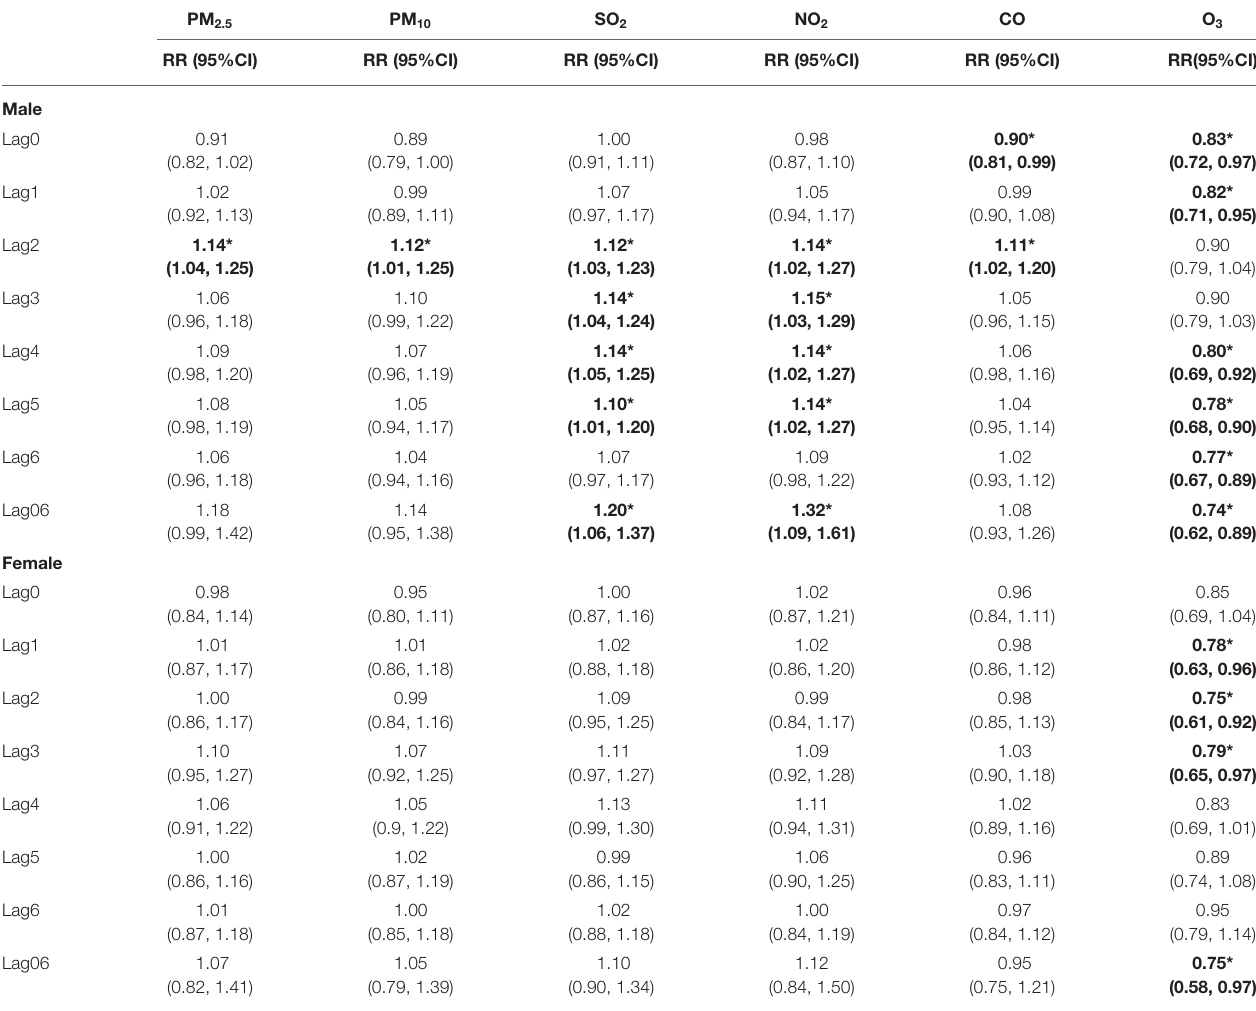
TABLE 5 | The relative risk (RR) of hospital admission for asthma in children per interquartile range (IQR) increase in different air pollutants in different lag days: single-pollutant model, stratified by gender. PM